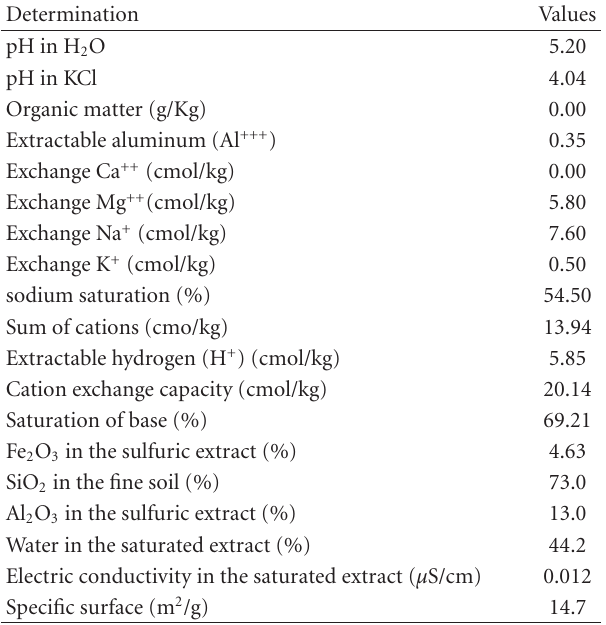
Table 3: Chemical characterization of the natural soil.